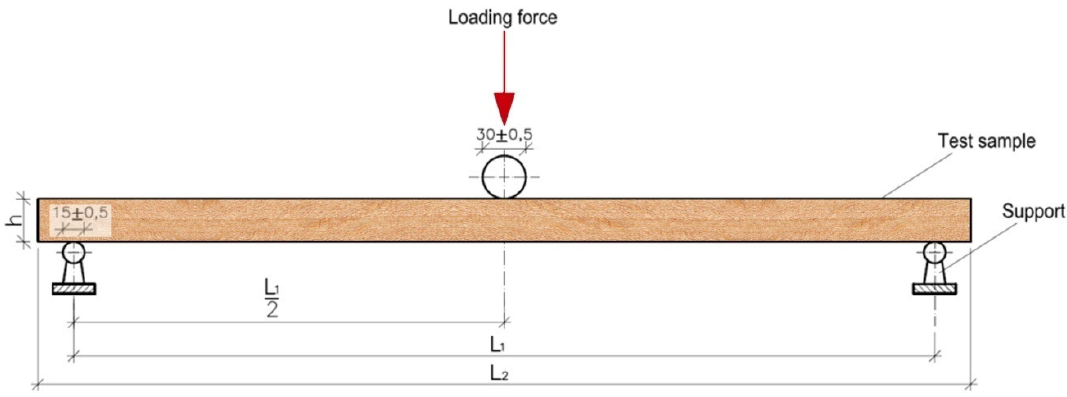
Figure 3. Principle of the three-point bending test ([33].